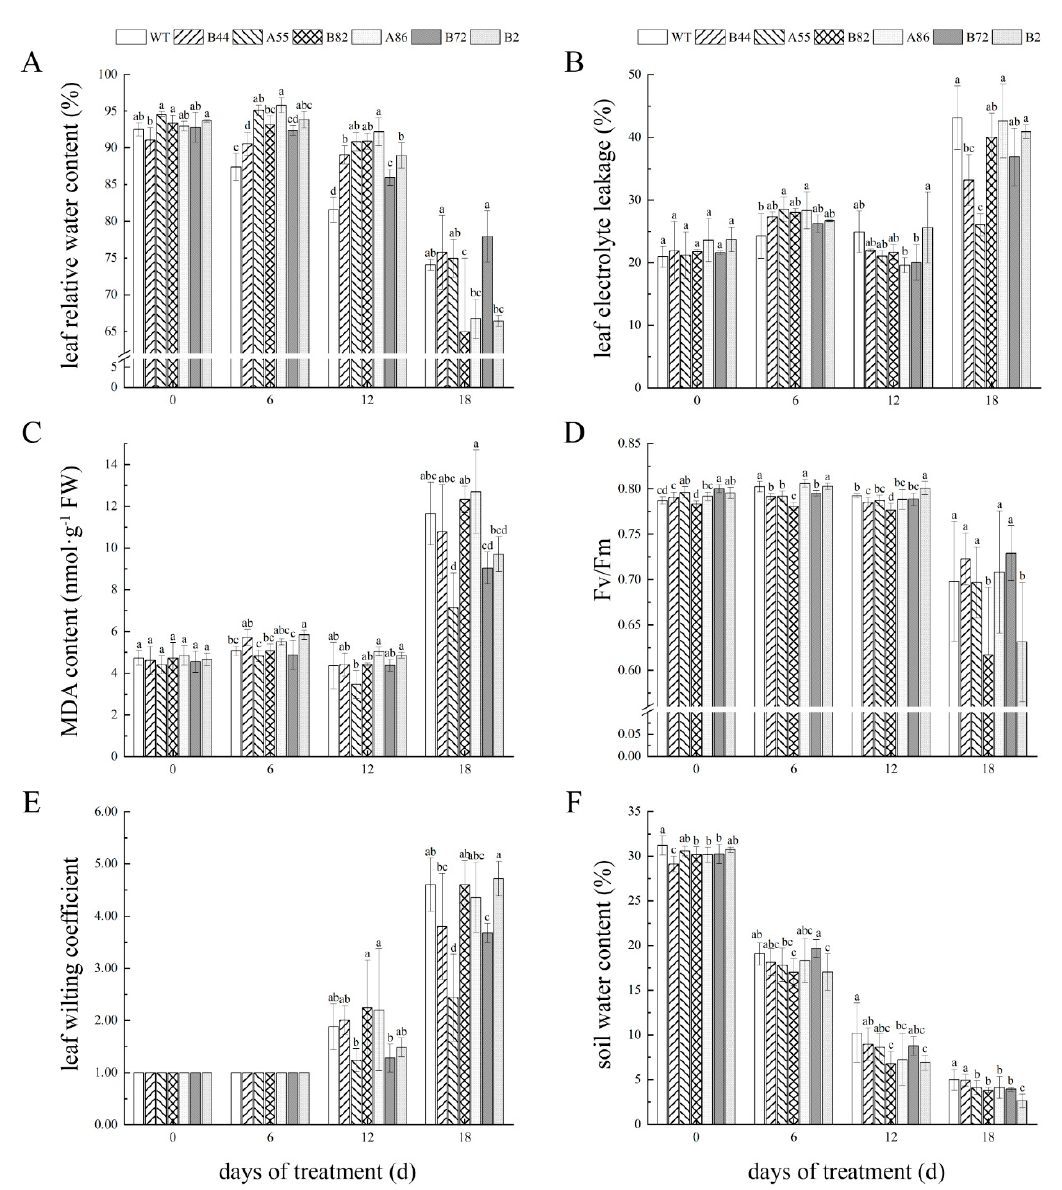
Figure 5. The changes of 6 physiological indexes under drought stress. ( A ) Leaf relative water content (RWC); ( B ) leaf electrolyte leakage (EL); ( C ) MDA content; ( D ) maximum photochemical efficiency of PS II (Fv/Fm); ( E ) leaf wilting coefficient; ( F ) soil water content (SWC); different lowercase letters in the same column indicate significant differences ( p < 0.05).